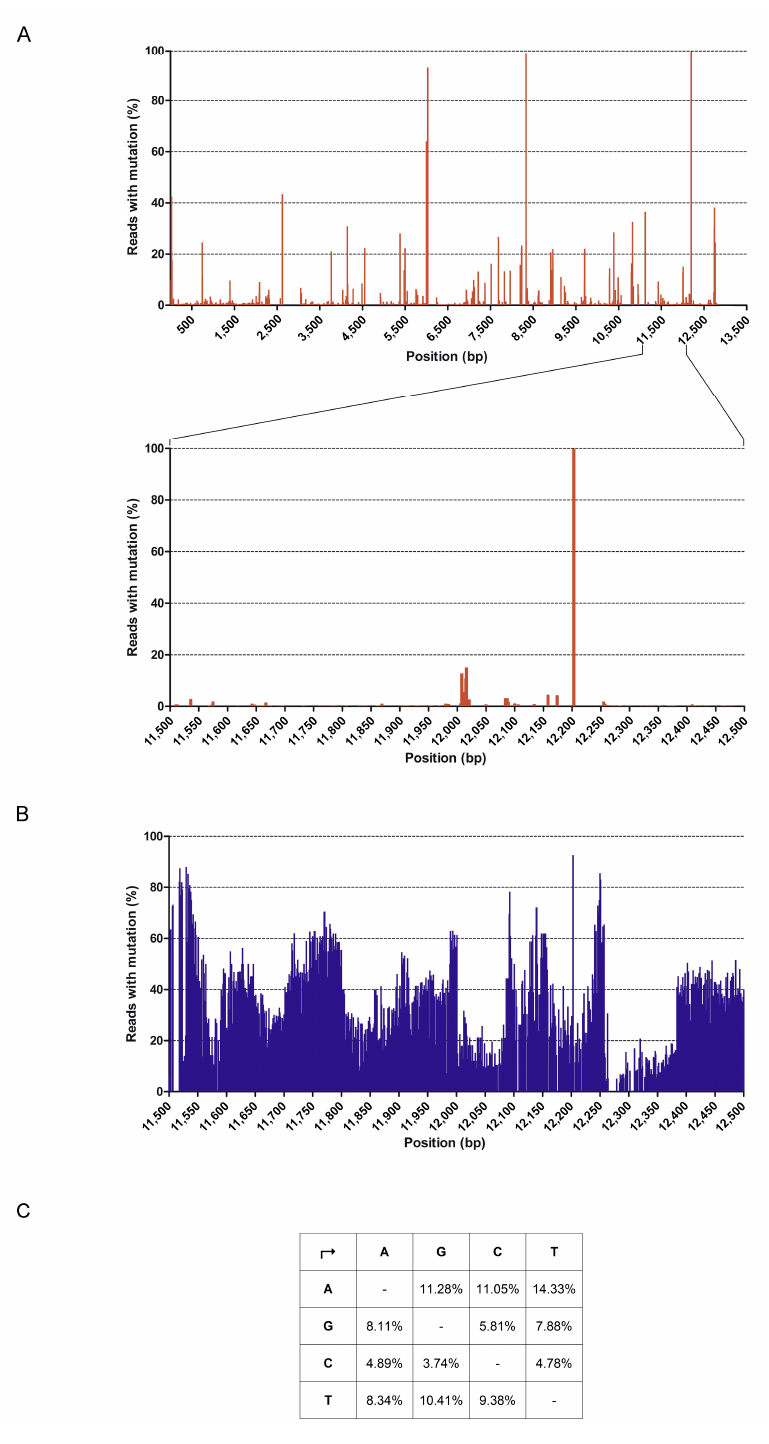
Figure 7. Sequence variability detected in the HMPV stock. ( A ) The upper graph represents the % of reads displaying mutations in comparison to the reference sequence AF371337.2 at each nt position detected, as assessed by NGS. Nt positions in the HMPV genome are reported in the x axis. An enlargement of nt positions 11,500–12,500 is also shown (lower graph). ( B ) Graph shows sequence variability at nt positions 11,500–12,500. Alignment to AF371337.2 was performed using NGS reads obtained by lowering homology parameters. ( C ) Table represents the % of bases substitution occurring at each nt position in comparison to Ref AF371337.2. Analysis was performed for the genome region at nt